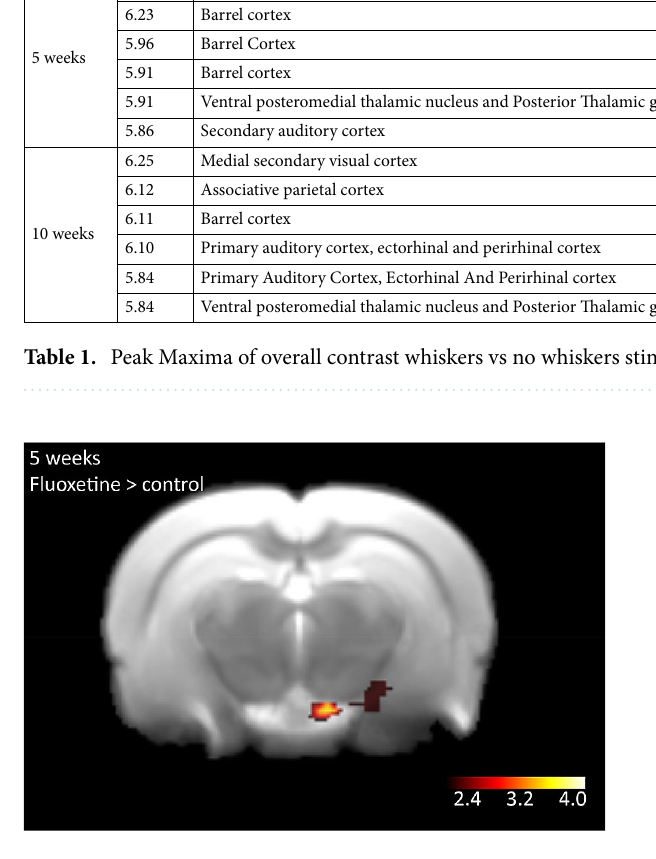
Figure 3. Results of the contrast perinatal SSRI exposure > control for the 5 weeks old rats. Whisker stimulation was given on the left side of the animal. Increased activity is observed in the hippocampal CA3 and dentate gyrus regions stretching to the mammillary body in the thalamus (cluster size = 72 voxels, z-max 1.9 p = 0.012). Significant clusters are shown upon an in-house rat template and z-scores are depicted in the